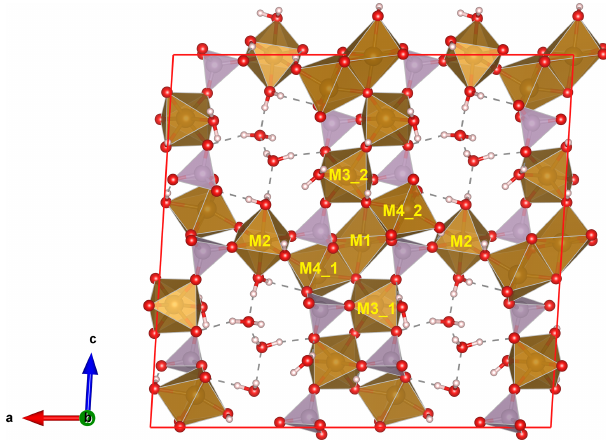
Figure 10. Crystal structure of beraunite viewed perpendicular to the crystal elongation. The heteropolyhedral slabs are connected by the M 2 octahedra; water molecules located in channels are hydro- gen bonded (dashed lines). P tetrahedrons are purple, O atoms red, and H atoms grey. The unit cell is